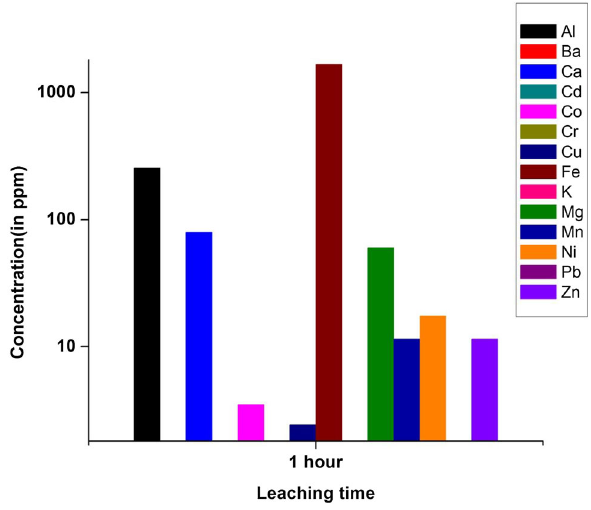
Fig. 30 Change in elemental concentration (in ppm) in aqueous leachates of Ledo coal (LC-60A) leaching for 1 h at 90 (cid:3)